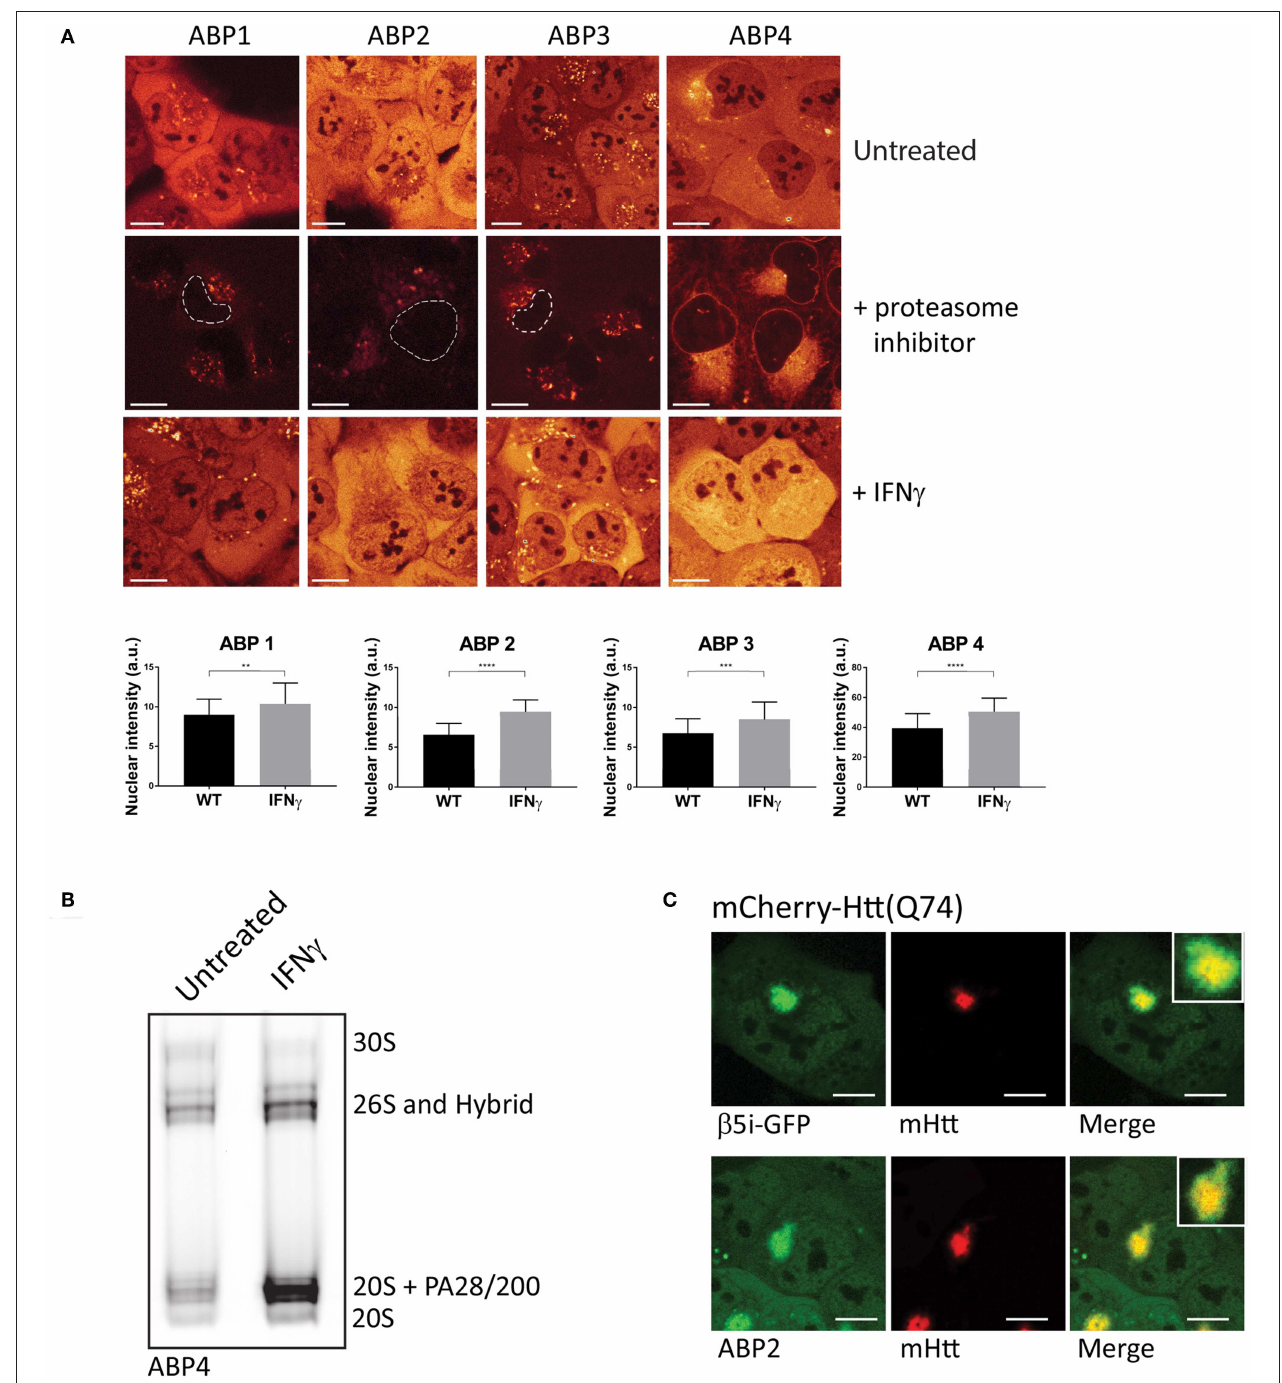
FIGURE 3 | Visualizing proteasome activity in living cells. (A) Proteasome activity labeling in living cells by different probes. U2OS cells were incubated with vinyl sulphone ( ABP1 , green and ABP3 , red) and epoxomicin ( ABP2 , green and ABP4 , yellow) based probes (upper panel). Pre-incubation with epoxomycin to block proteasome activity was used to determine nonspecific binding (middle panel). Epoxomycin-based probes give more intense labeling pattern, while the Cy3 fluorophore gives more background staining. When U2OS cells were stimulated for 72h with IFN- γ , subsequent activity labeling showed a significant increase in labeling (lower panel, graphs). (B) U2OS cells were stimulated with IFN- γ , labeled with ABP4 and analyzed by native PAGE, confirming increased ABP labeling as shown by microscopy. (C) Recruitment of active proteasomes into aggregates. U2OS cells were transfected with polyglutamine-expanded huntingtin fragments to initiate aggregation, and co-transfected with β 5i-GFP to show proteasome distribution around aggregates. Incubation with ABP2 showed a similar distribution pattern as β 5i-GFP, indicating the recruitment of catalytically active proteasomes into aggregates. Scale bar = 5 µ m.